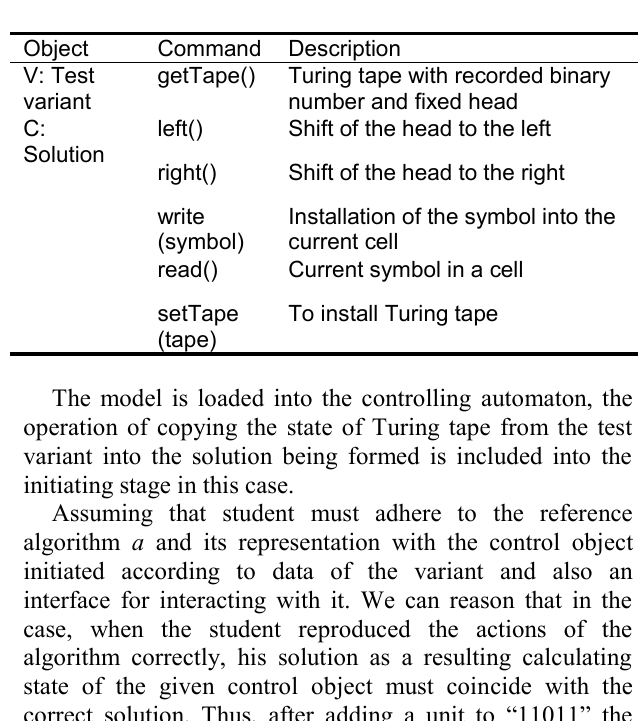
Table 1. Commands of the test variant